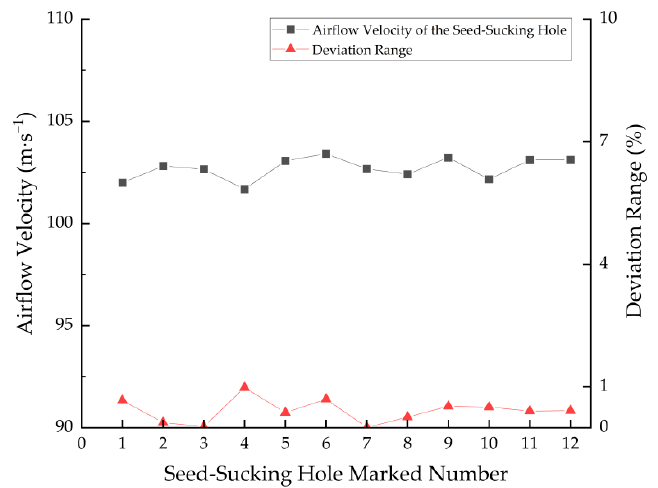
Figure 8. The line chart of the airflow velocity of seed-sucking holes with the optimal parameter combination.